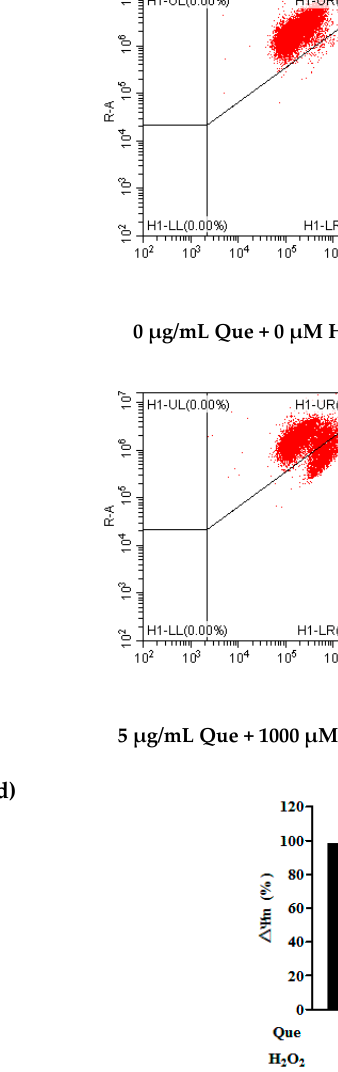
Figure 6. Effects of Que on ROS generation and ∆ ψ m of IPEC-J2 exposure to H 2 O 2 . ( a ) Flow detection diagram of ROS content of IPEC-J2; ( b ) Histogram of ROS content of IPEC-J2. ( c ) Flow detection diagram of ∆ ψ m of IPEC-J2; ( d ) Histogram of ∆ ψ m of IPEC-J2. Data are presented as mean ± SD. * p < 0.05 means significant difference between two groups.